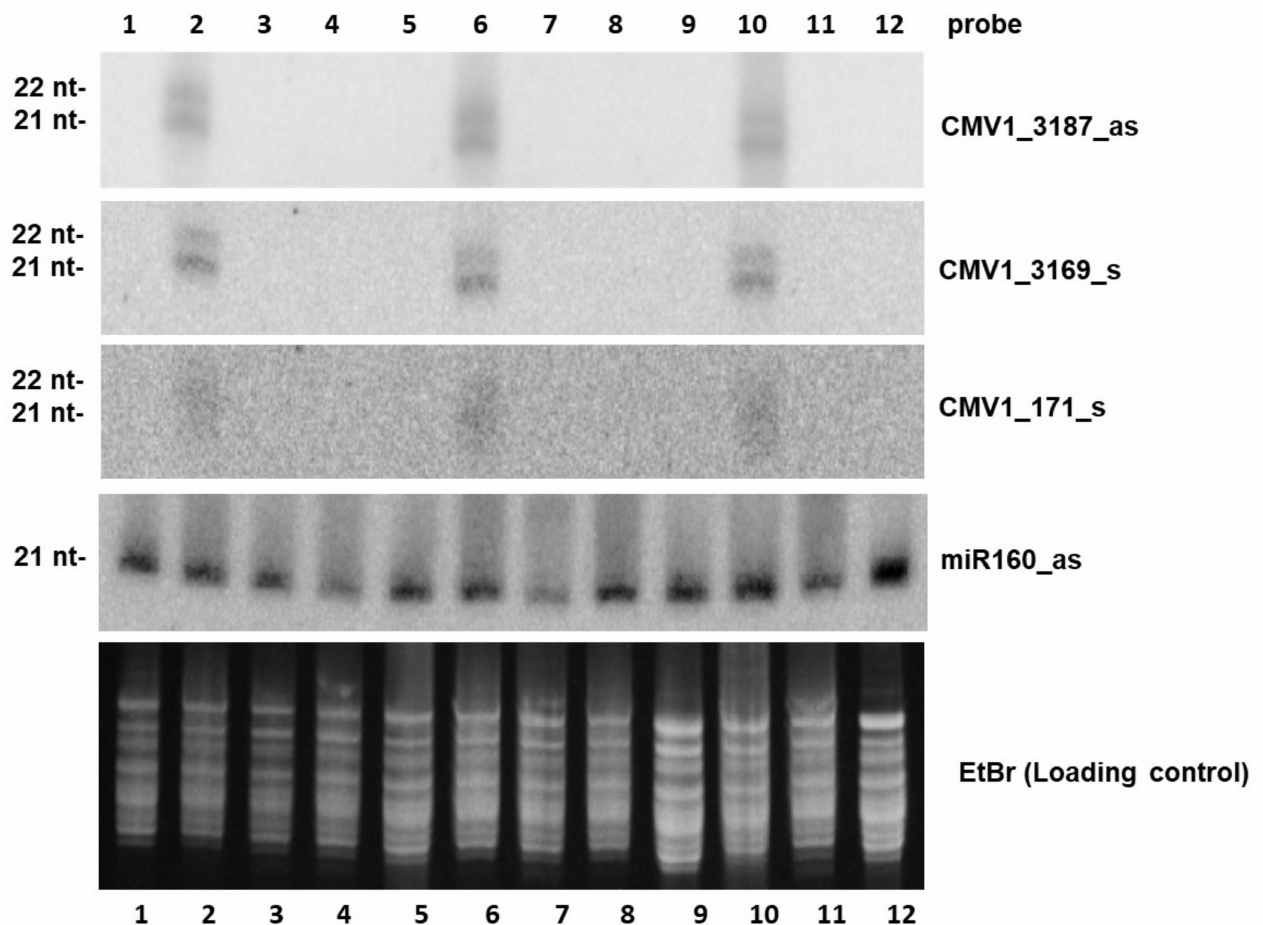
Figure 4. Small RNA blot hybridization analysis of CMV-infected, dsRNA treated and negative control tobacco plants. Total RNA samples resolved by electrophoresis on a 15% polyacrylamide gel stained with ethidium bromide (EtBr) and then transferred to a nylon membrane. The membrane was successively hybridized with p 32 -labeled DNA oligonucleotide probes specific to CMV RNA1-derived antisense (CMV1_3169_s and CMV1_171_s) and sense (CMV1_3187_as) siRNAs and plant miRNA160 (miR160_as). After each hybridization, the membrane was exposed to a phosphor screen for 20 hrs to 6 days and then scanned using a Phosphor Imager. The RNA samples are derived from: the 3rd leaf of mock inoculated plants (Lanes 1, 5, 9); a pool of leaves from plants inoculated with CMV showing symptoms (Lanes 2, 6, 10); the 3rd leaf (Lanes 3, 4, 7) or the 2nd leaf (Lane 11) or the 4th leaf (Lane 12) of a plant inoculated with CMV and treated with in vivo dsCP, not showing symptoms; the 3rd leaf of a plant inoculated with CMV and treated with in vivo ds2b, not showing symptoms (Lane